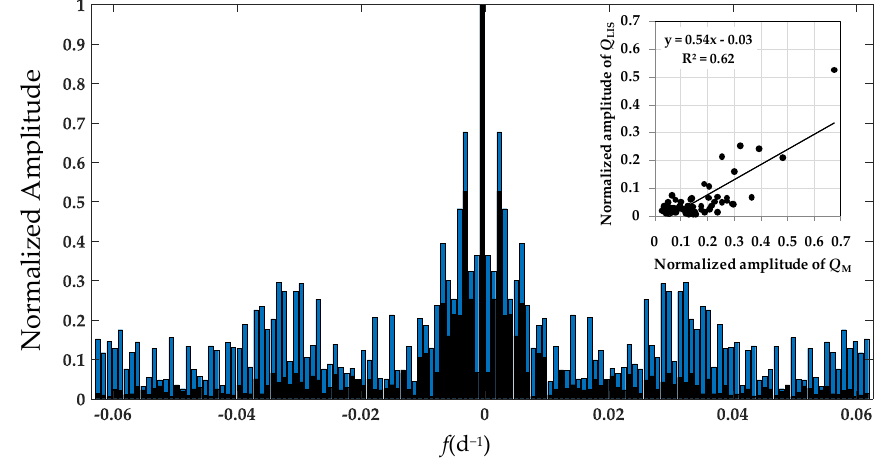
Figure 2. Normalized fast Fourier-transformation (FFT) spectra of LISFLOOD modeled discharge, Q LIS (black bars), and discharge measured in situ at the Drasi gauge station, Q M (blue bars) in the frequency domain. The reference component has been normalized to a magnitude of unity and all other components have been scaled by the same amount.